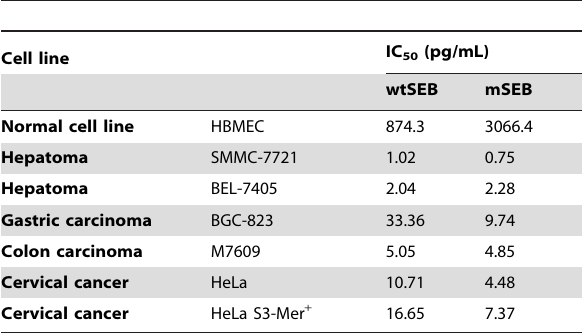
Table 1. The protein concentration at which the cell growth was inhibited by 50% (IC 50